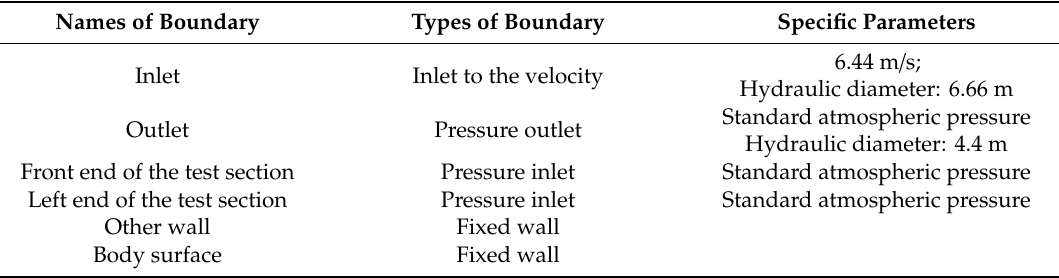
Table 2. Boundary condition settings.